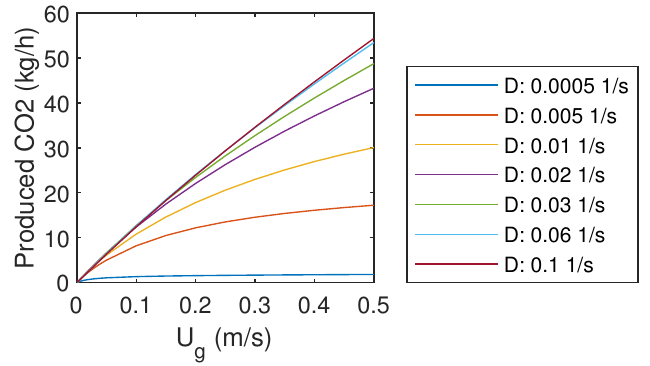
Figure 5. Product gas CO 2 mass flow